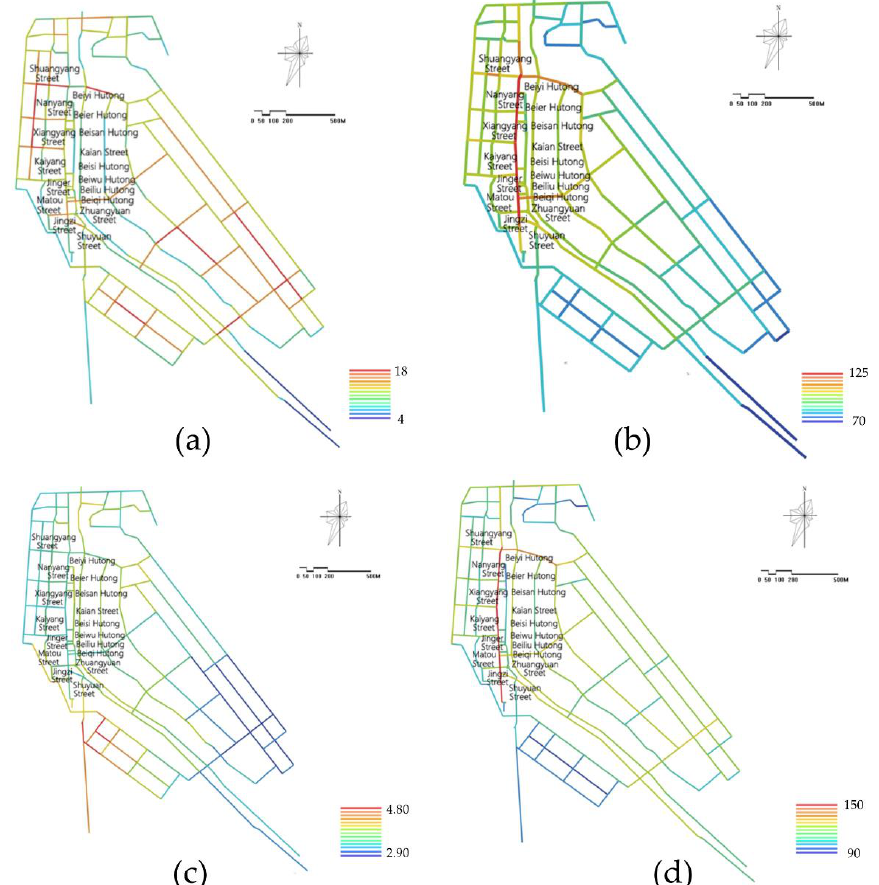
Figure 3. The space syntax model analysis result on Nanyang town: ( a ) connectivity value, ( b ) local integration value, ( c ) mean depth value and ( d ) global integration value.